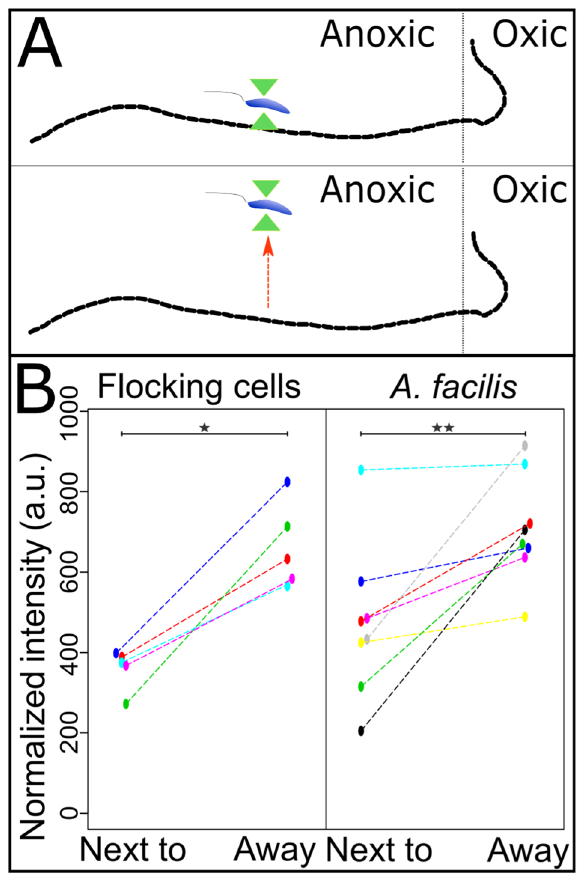
Fig. 4 | Cytochromes in fl ocking bacteria are more oxidized when close to a cable bacterium. A Schematic representation of the experiment. A fl ocking cell is captured and moved right nextto a cable bacterium fi lament, measured byRaman microscopy, then moved ~50 – 100 µ m away and measured again after ~3s. B The change in normalized intensity of the 750cm − 1 band for each individual cell when moved nextto and away from the cable bacterium. The 750cm − 1 band is indicative of cytochrome redox state, with high values for reduced and low values for oxi- dized cytochromes. Band intensities and, thus, cytochrome redox states are sig- ni fi cantly different between the two positions ( N native cells =5, p -value=0.015, indicated by *; N A.facilis =8, p -value=0.0387 indicated by **, two-sided t -test for dependent samples,); a.u., arbitrary units. Source data are provided as a Source Data fi